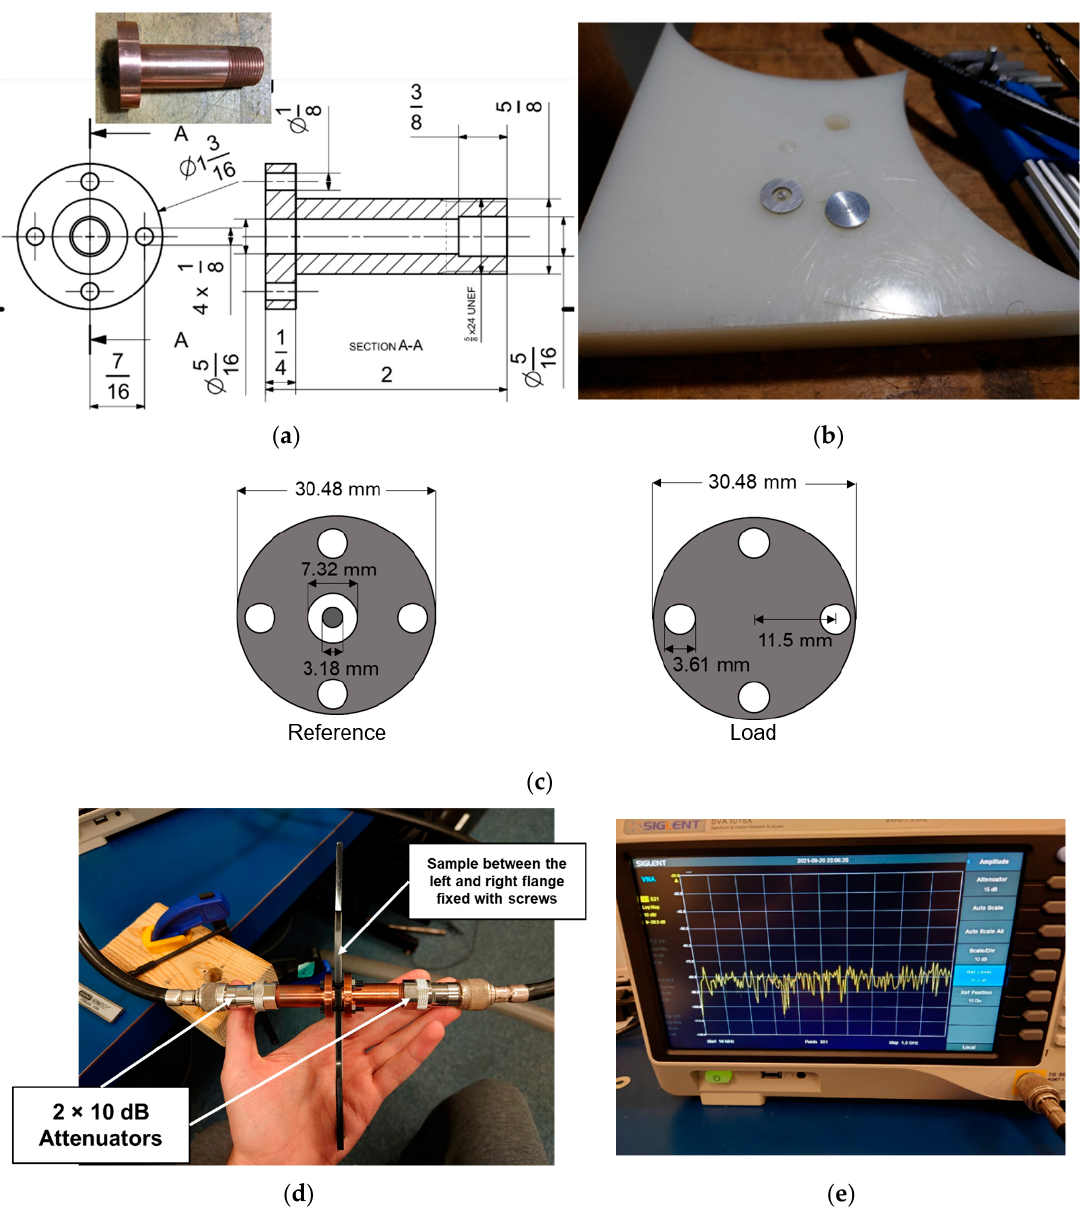
Figure 4. ( a ) Dimensions of one-half of the coaxial fixture used in the experiments; ( b ) cut sample materials with specific geometry; ( c ) dimensions of the reference and load samples; ( d ) coaxial fixture made of copper with two terminals connected to the vector network analyzer with the test sample between the two center flanges, according to the ASTM 4935-99; ( e ) vector network analyzer. A vector network analyzer, Siglent SVA1015X, shown in Figure 4d, with a frequency range from 9 kHz to 1.5 GHz, was used to quantify the EMI SE of the samples in a